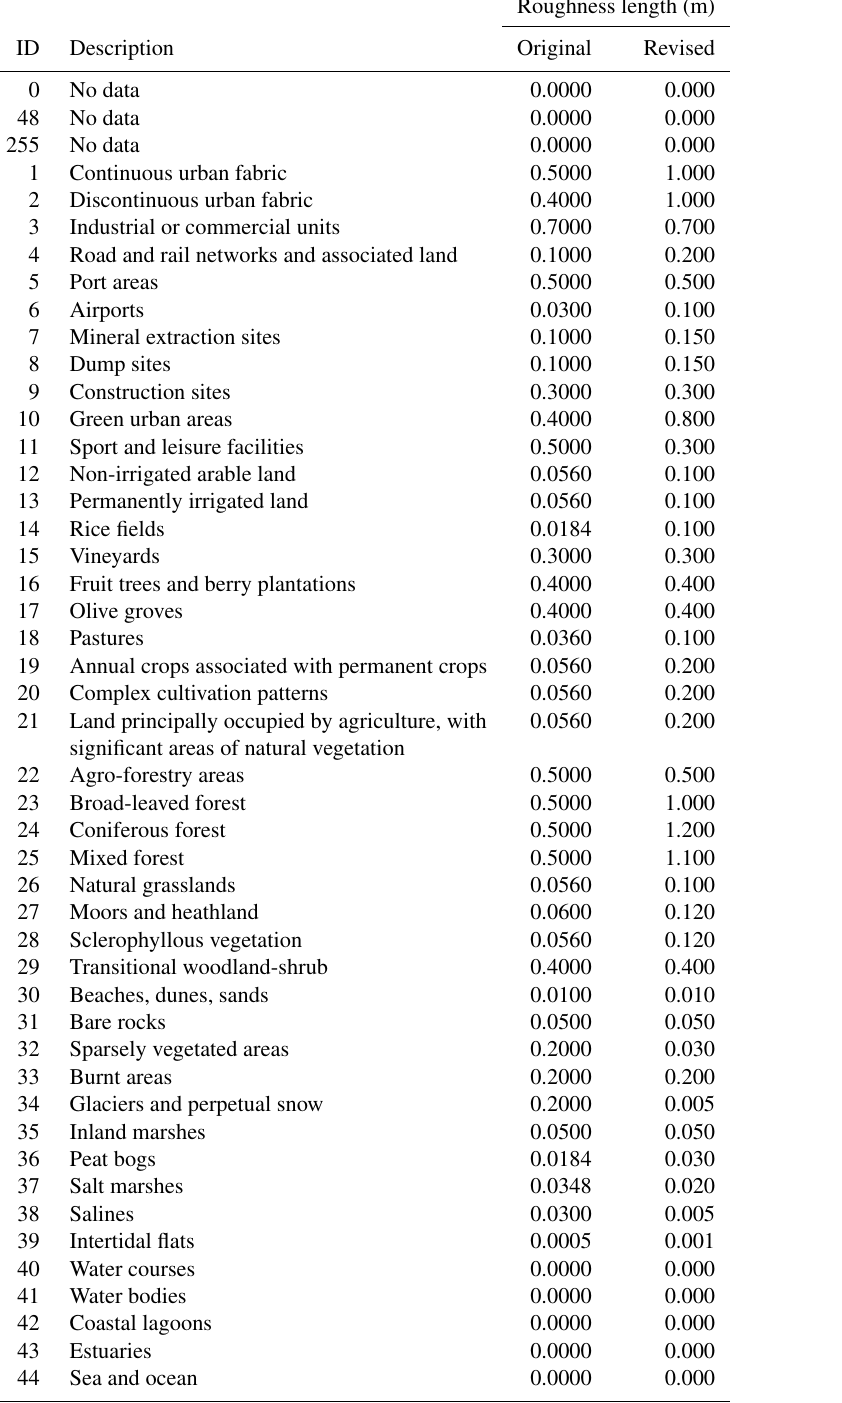
Table A4. Land cover table used for the CORINE database (Thøgersen,